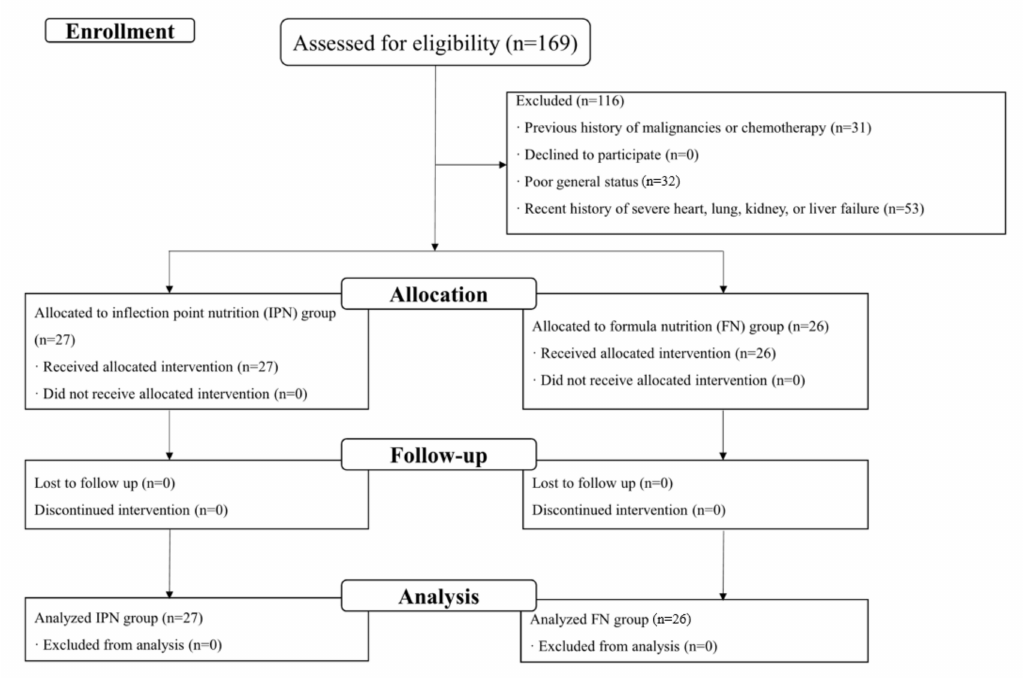
Figure 1. Flow diagram of the sequence through the stages of an